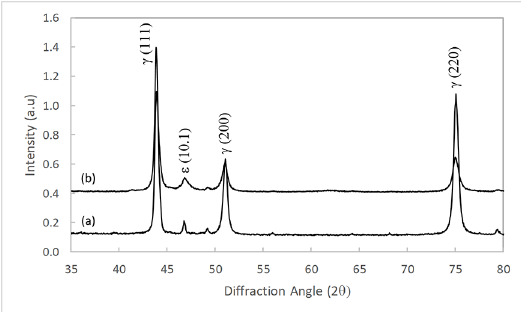
Figure 7. X-Ray Diffraction Patterns: (a) ST + 2ECAE + 650ºC, (b) ST + 2ECAE + 650ºC + 4 % compressive strain.